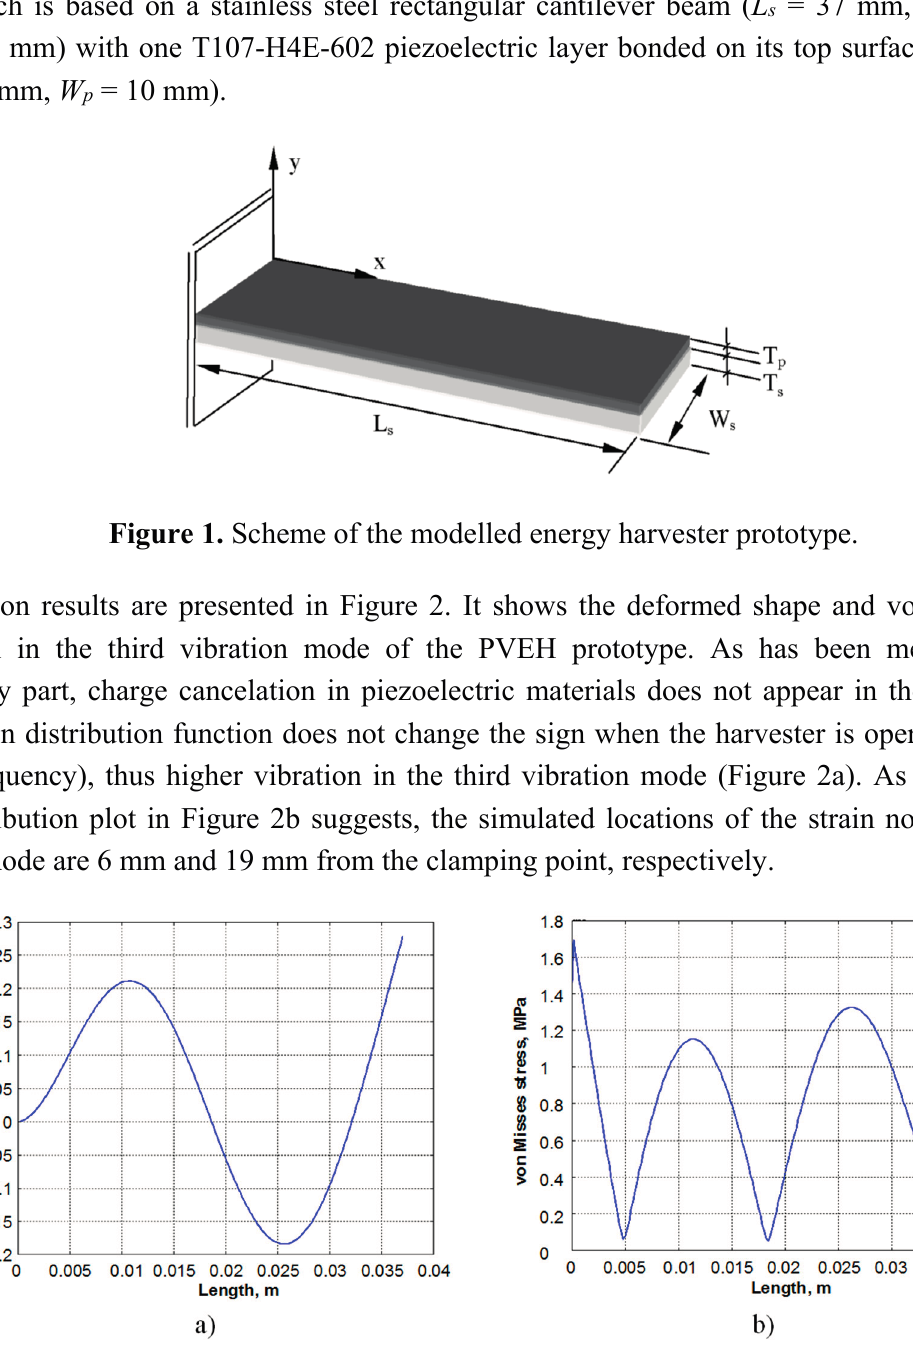
Figure 2. Deformed shape ( a ) and von Misses stress distribution ( b ) for the third vibration mode of the energy harvester